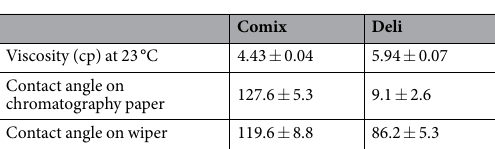
Table 1. Viscosity and contact angle of Comix and Deli